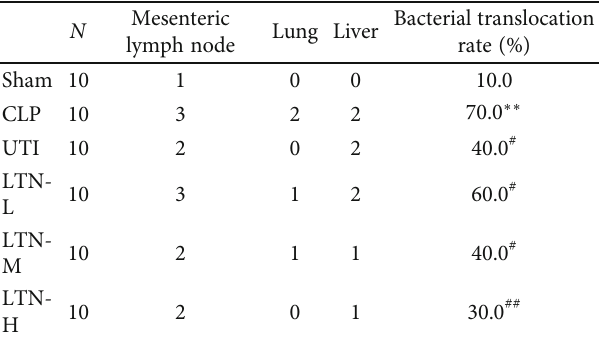
Table 1: Comparison of bacterial translocation rate in organs of mice in each